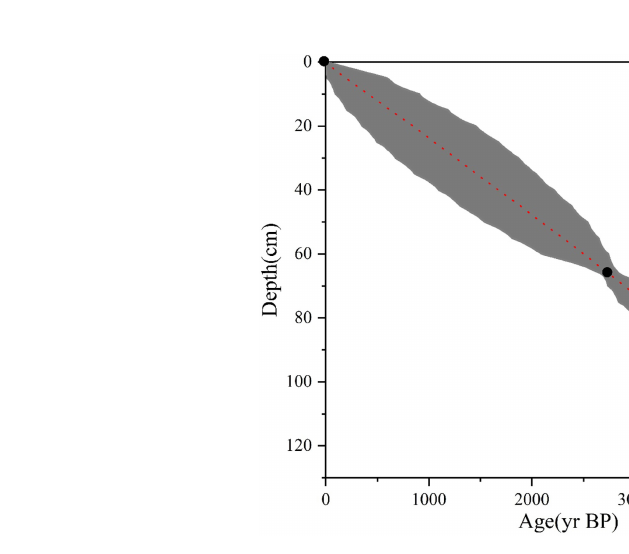
FIGURE 3 The depth-age model of the T7 west wall section.